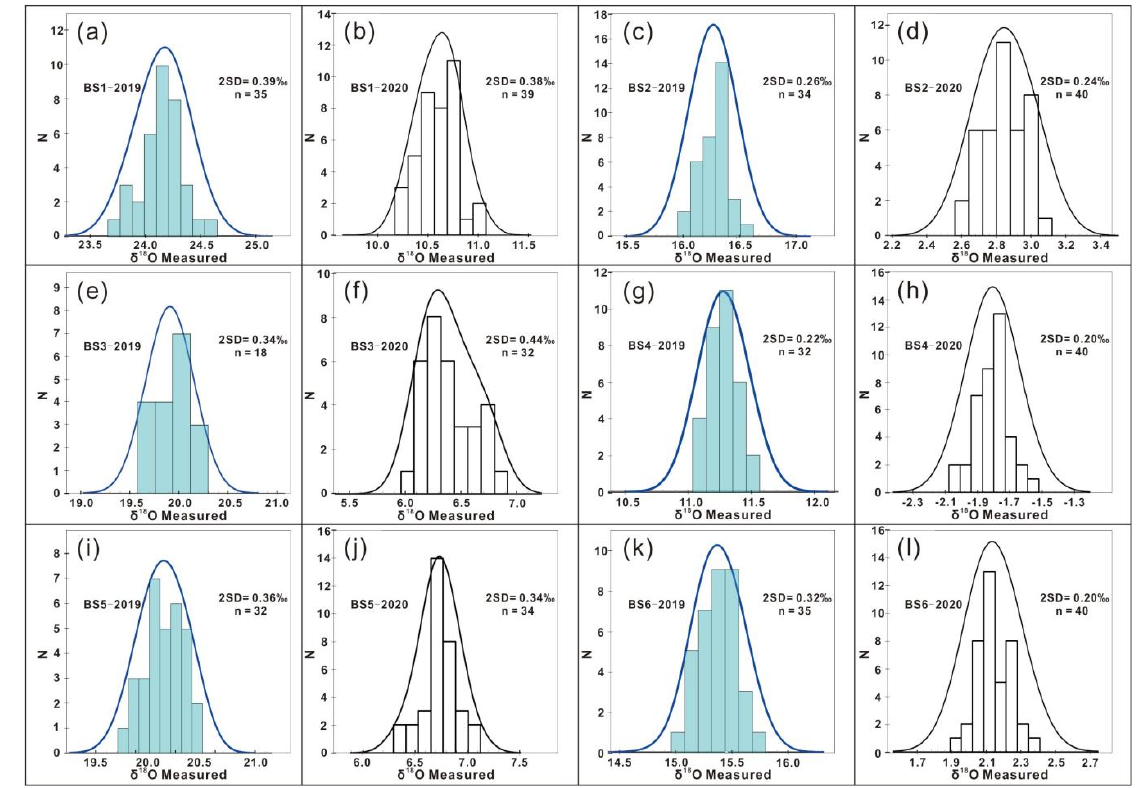
Figure 4. Frequency distributions of SIMS-measured apparent δ 18 O values of the six beryl samples: ( a ), ( c ), ( e ), ( g ), ( i ), and ( k ) are the SIMS-measured apparent values of δ 18 O of BS1, BS2, BS3, BS4, BS5, and BS6, respectively, in the first session; ( b ), ( d ), ( f ), ( h ), ( j ), and ( l ) are the SIMS-measured apparent values of δ 18 O of BS1, BS2, BS3, BS4, BS5, and BS6, respectively, in the second session.